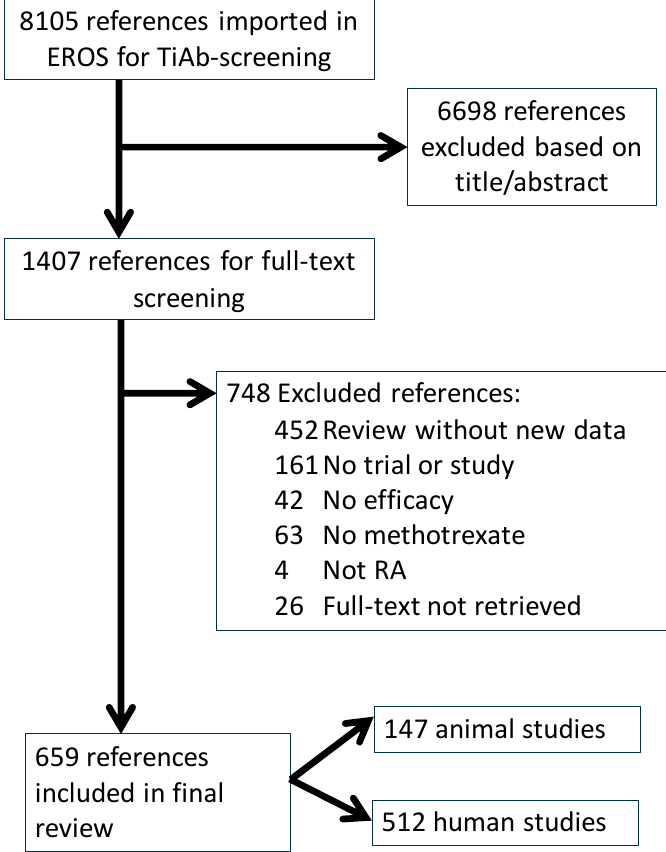
Figure 1. Paper flow.